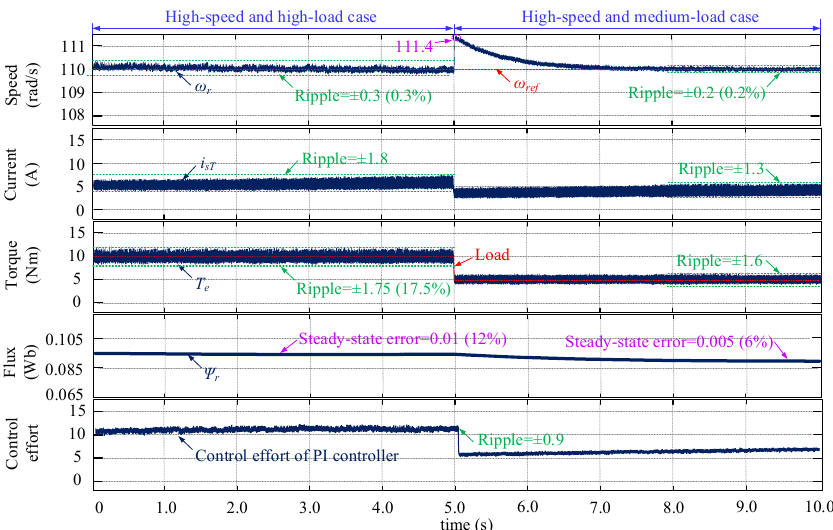
Figure 9. Performance of proposed FCS-MPTC with fixed PI parameters but adaptive weighting factor. On the other hand, for the purpose of verifying that the proposed FCS-MPTC (with adaptive PI controller parameters and adaptive weighting factor) is able to attenuate the system ripples caused by the external factors, assuming that the speed sensor has random errors, the control performance of the traditional and the proposed FCS-MPTC strategies are compared. In the simulation, random errors were added to the measured speed to form the feedback speed, and the simulation process was conducted in the same way as before. Figures 10 and 11 demonstrate the control performance of the traditional FCS- MPTC, and the proposed FCS-MPTC, respectively. First of all, compared to the results in Figure 8, the speed, current and torque ripples in Figure 10 witness a significant increase when the external disturbances are applied to the system. In detail, in the high-load situ- ations, the speed, current and torque ripples are ±0.8 rad/s (0.8%), ±3 A, and ±4.8 Nm (48%), respectively, and in the medium-load condition, they are ±0.9 rad/s (0.9%), ±3.5 A, and ±5 Nm (50%), respectively. Obviously, the system performance, especially the torque ripples, cannot meet the requirements in Table 4, and the speed ripples are very close to the upper limit. Secondly, it can be noticed that after using the proposed FCS-MPTC method with adaptive PI controller parameters and adaptive weighting factor, the steady-state perfor- mance of the system has been improved greatly. Specifically, the speed ripples in the high- torque and medium-torque conditions are ±0.5 rad/s (0.5%) and ±0.55 rad/s (0.55%), re- spectively. As for the current ripples, the magnitude of them decreases by 1.1 A under 10 Nm. Most importantly, the torque ripples are only 2 Nm (20%) at the rated working point, satisfying the requirement, though the ripples in percentage for medium-load condition are still high (44%) due to the lower torque base value. These prove that the proposed FCS-MPTC has great capacity in suppressing the system ripples. Finally, being similar to Figures 8 and 9, the flux ripples in Figure 11 are small, but there still exist steady-state errors.